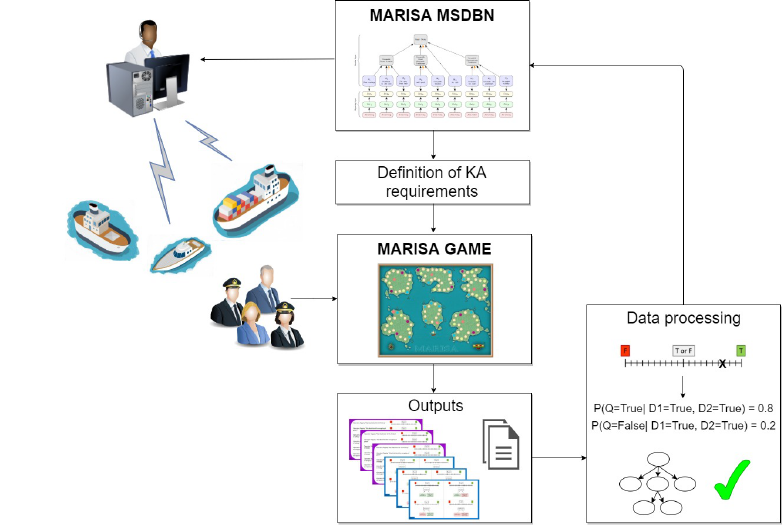
Figure 1. The knowledge acquisition (KA) approach discussed in this